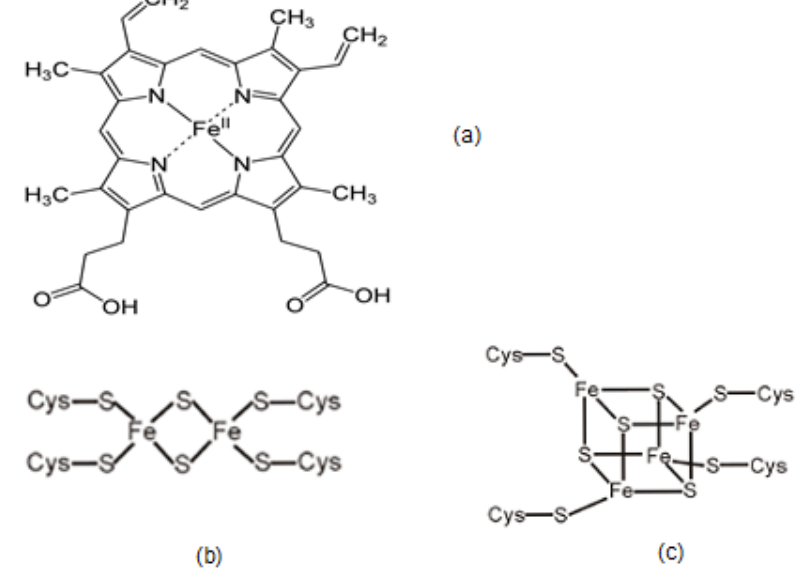
Figure 1. Chemical structure of heme ( a ) shows the prosthetic groups in heme-containing proteins, involved mainly in oxygen and electron transport. The chemical structure of the ( b ) iron sulfur (2Fe-2S) and ( c ) cuboidal iron sulfur (4Fe-4S) prosthetic groups found in iron sulfur proteins are involved mainly in electron transport.